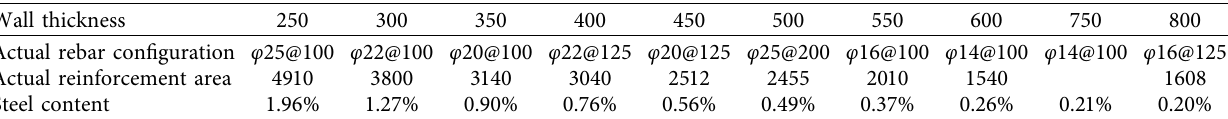
Table 4: Rebar configuration and steel content selected by the principle of minimizing reinforcement area. Wall